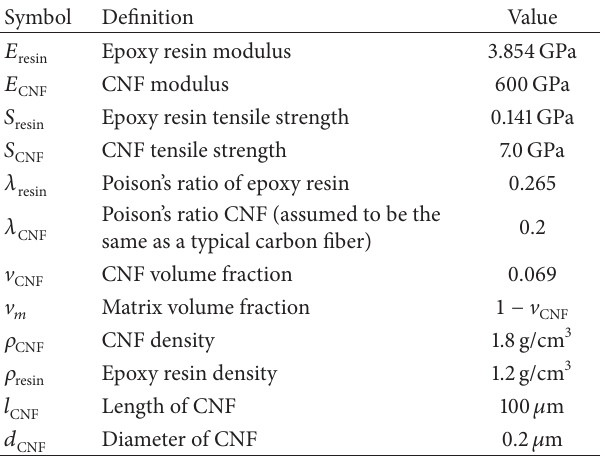
Table 2: The materials properties [16–18] used in the micromechan- ics model.